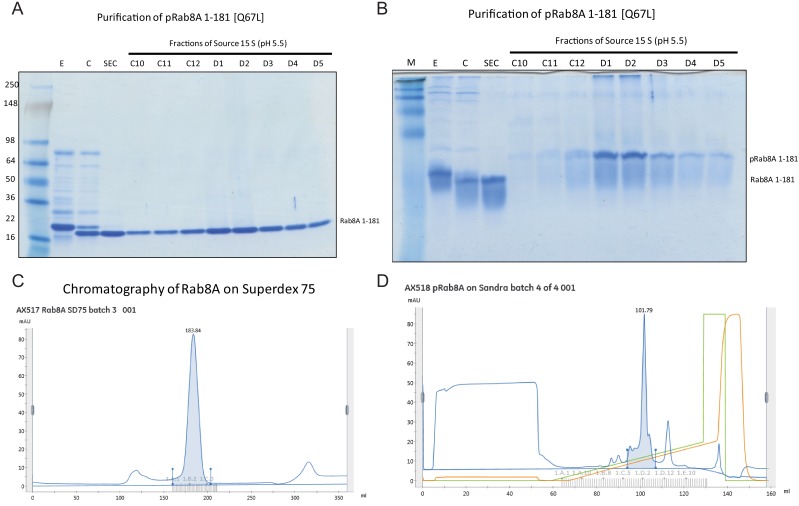
Purification and characterization of Thr72 phosphorylated Rab8A[1–181, Q67L].(A) Coomassie stained 4–20% gradient SDS polyacrylamide gel electrophoresis analysis of the purification of pRab8A 1–181 [Q67L]. Lane M = See Blue Plus Marker (Invitrogen); Lane E = His-Rab8A eluted from Ni-agarose. Lane C = Rab8A cleaved with Thrombin, dialyzed and depleted on Ni-agarose; Lane SEC = monomeric Rab8A after size exclusion chromatography; C10 – D5 = fractions of a 10 ml Source S column containing phospho-Rab8A 1–181 [[Q67L]. (B) Coomassie stained 12% Phos-tag SDS polyacrylamide gel electrophoresis analysis of the purification of pRab8A 1–181 [Q67L]. Lane M = See Blue Plus Marker (Invitrogen); Lane E = His-Rab8A eluted from Ni-agarose. Lane C = Rab8A cleaved with Thrombin, dialyzed and depleted on Ni-agarose; Lane SEC = monomeric Rab8A after size exclusion chromatography; C10 – D5 = fractions of a 10 ml Source S column containing phospho-Rab8A 1–181 [[Q67L]. (C) Chromatogram (UV280 nm) of Rab8A 1–181, separated on a Superdex 75 XK 26/60 column. Equipment: Äkta Pure. Evaluation Software: Unicorn 7.1. Monomeric Rab8A eluted at 183.84 ± 10 ml. (D) Chromatogram (UV280nm) of Rab8A 1–181, separated on a Source 15 S HR10/10 column. Equipment: Äkta Pure. Evaluation Software: Unicorn 7.1. Phosphorylated Rab8A eluted at 101.79 ± 10 ml.